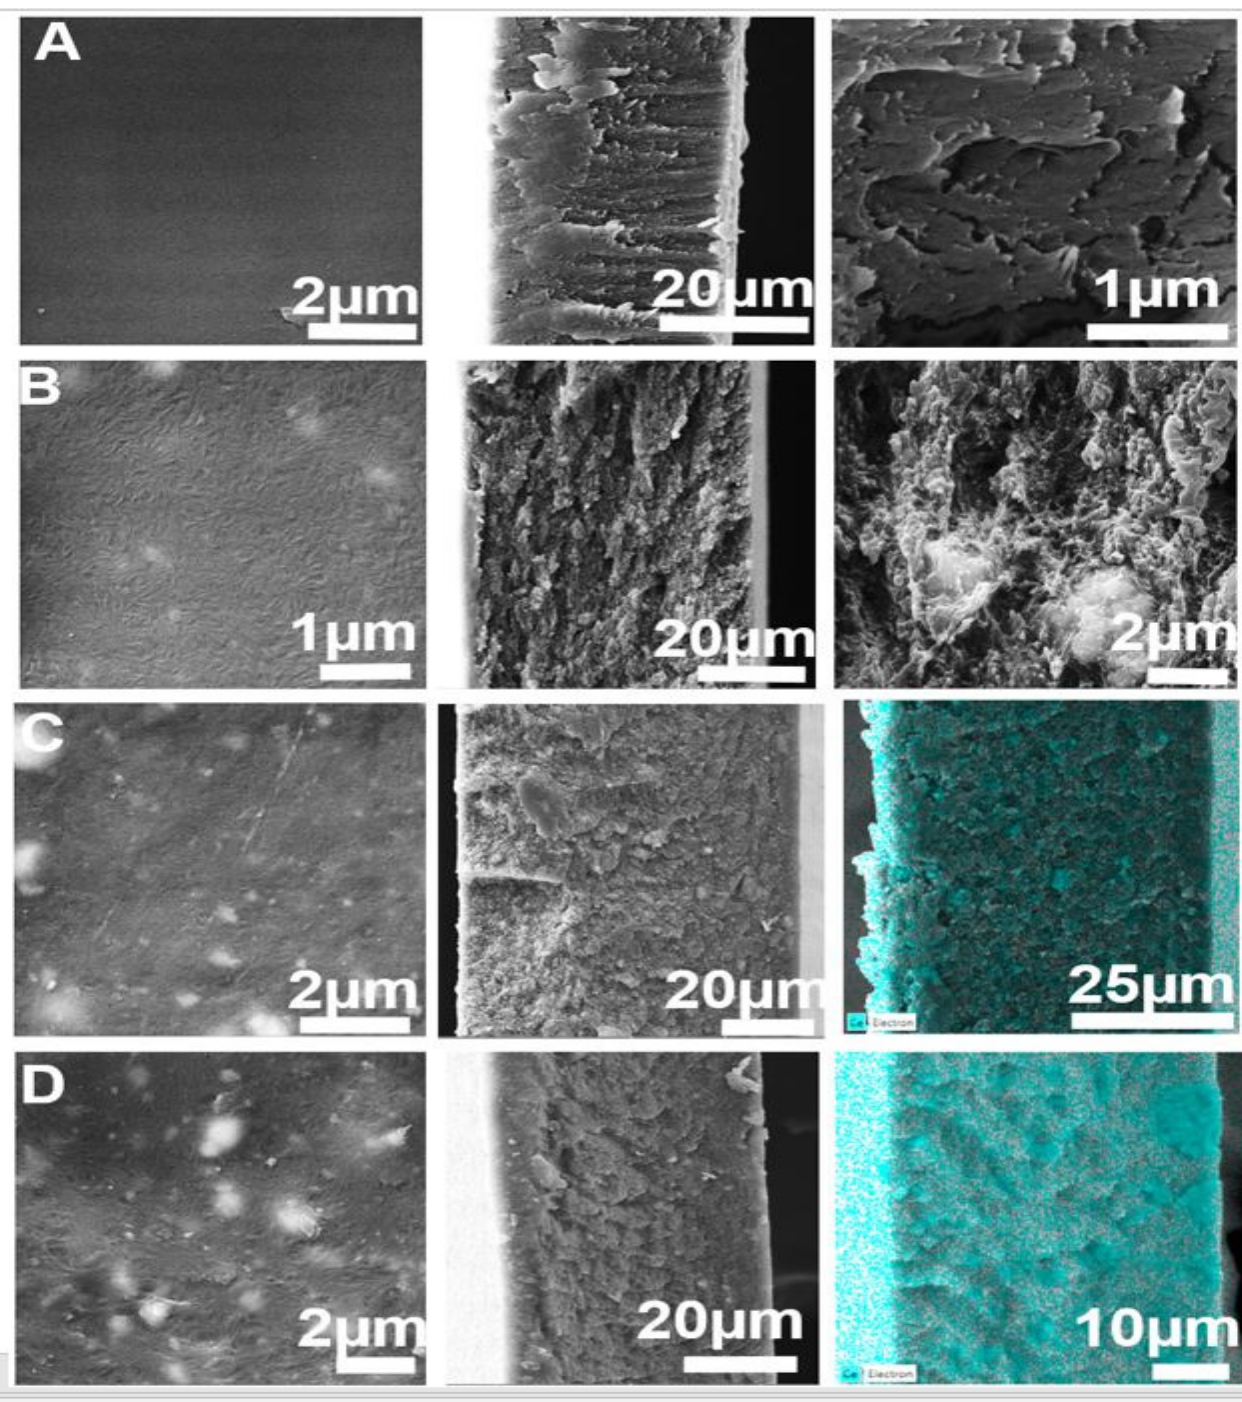
Figure 3. SEM images of the surface, cross-section, the magnified portion of the cross-section and EDS overlaid images: